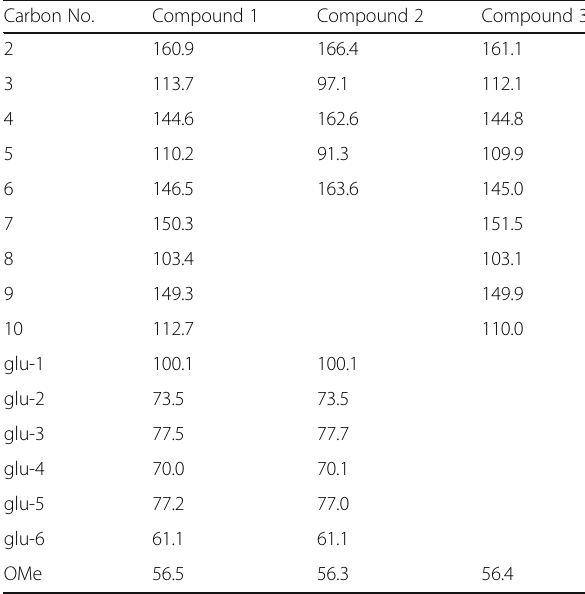
Table 2 13 C-NMR spectral data of AI 1~3 (DMSO- d 6 )